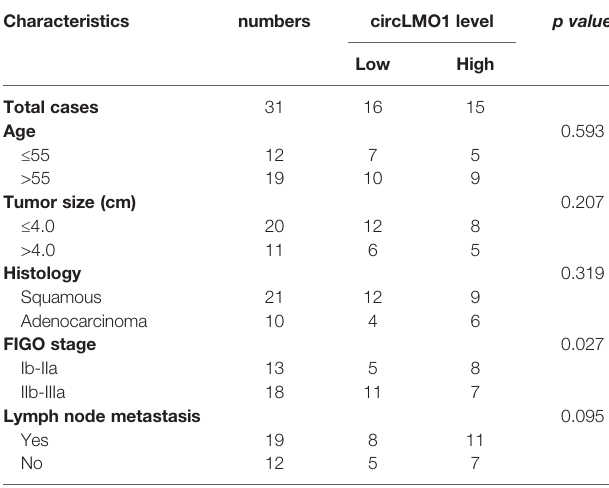
TABLE 1 | The correlation of circLMO1 level with clinicopathological characteristics in cervical